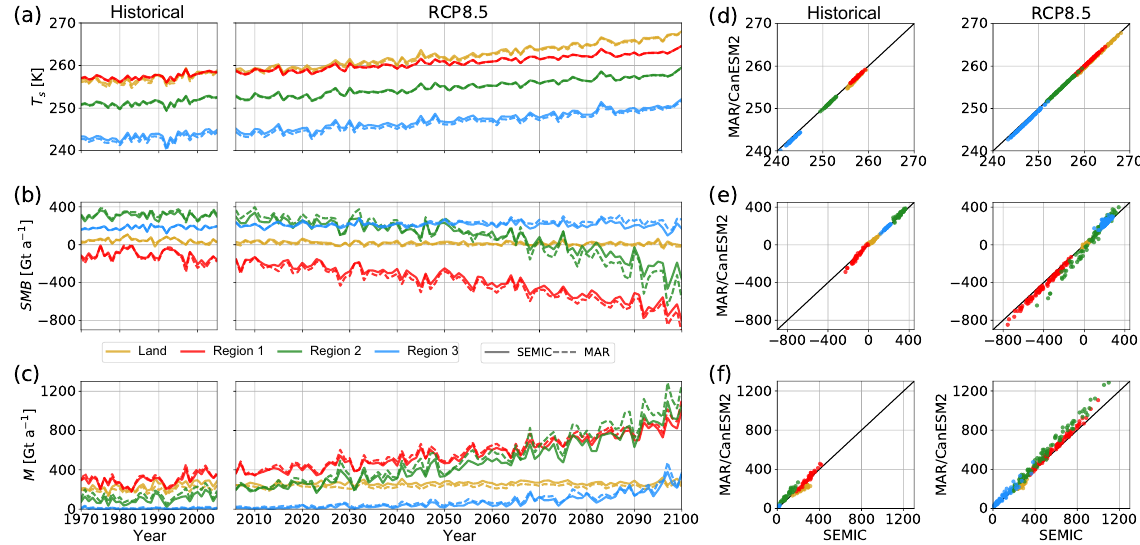
Figure 10. Annual mean, region-averaged surface temperature T s (a) , surface mass balance SMB (b) , and surface melt M (c) for SEMIC (solid lines) and MAR (dashed lines) using the optimal parameter values from Table 3. Point-to-point comparison of the two models (d–f) ; variables and units as in the left panel (a–c)